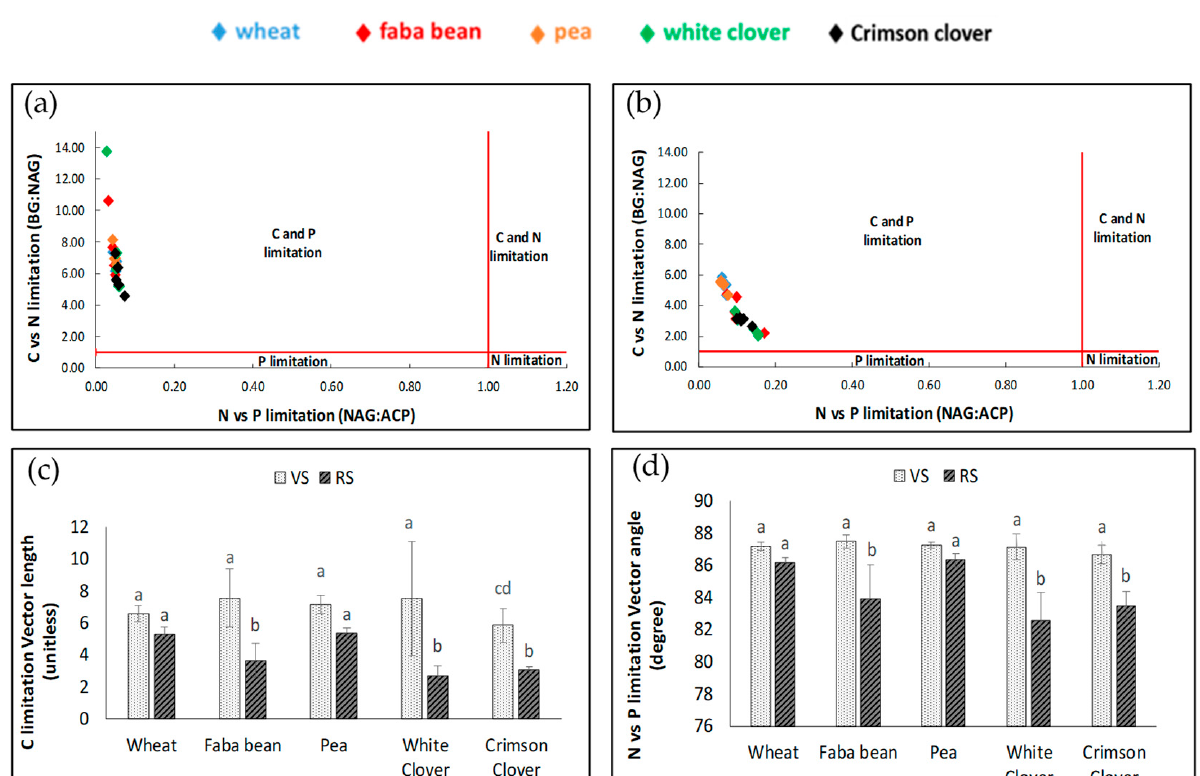
Figure 4. Enzyme stoichiometry under all studied plants species for identifiyng potential ressource limitation at the two development stages. ( a , b ) Scatter graphs of enzyme stoichiometry corresponding to the ratio of BG:NAG according the ratio of NAG: ACP at VS ( a ) and RS ( b ). BG: β -glucosidase; NAG: N-acetyl-glucosaminidase; ACP: acid phosphatase; VS: vegetative stage; RS: reproductive stage. To identify potential ressource limitation in soil according to Hill et al. [71], 1 was used as a horizontal and vertical baseline along the axis of enzyme activity ratios, and four different groups of microbial resource limitations (N limitation, P limitation, C and P limitation and N and P limitation) were categorized. ( c ) Vector length and ( d ) vector angle calculated according to enzymes ratios. Longer vector L indicates greater C limitation. A vector angle of <45 ◦ denotes N limitation; angles > 45 ◦ denote P limitation. Data are mean ± SD ( n = 5). Letters indicate statistically significant difference between plants species at p < 0.05 according to Tukey’s test.